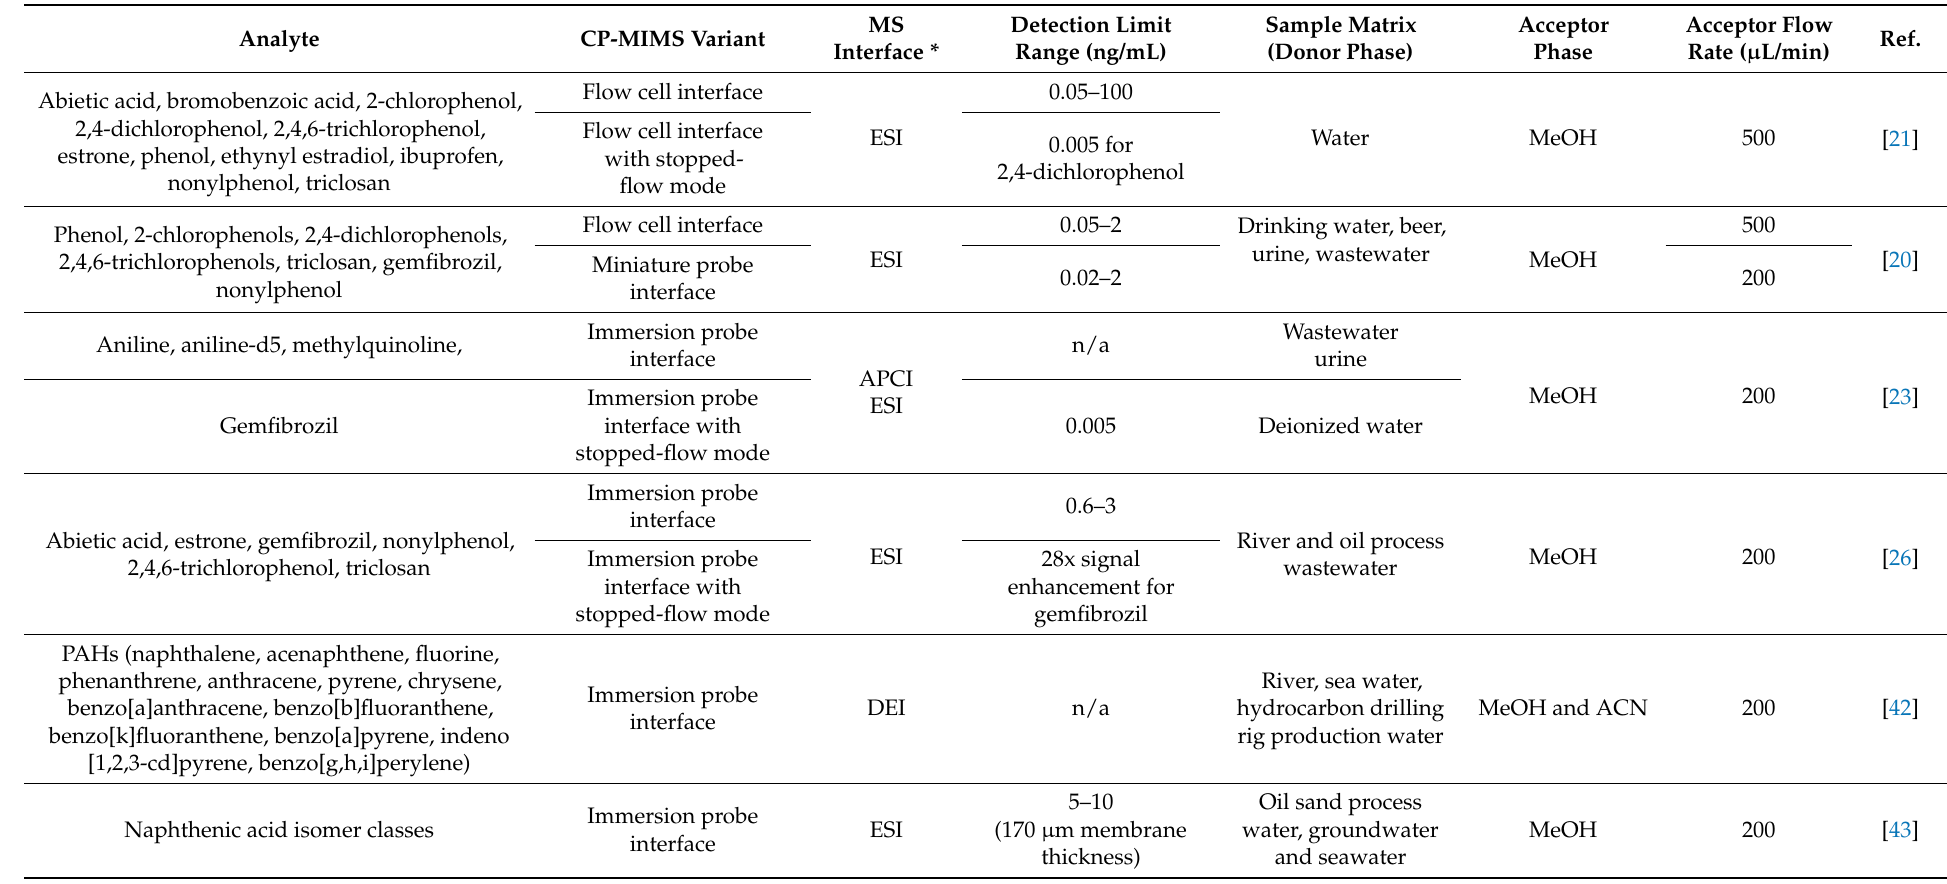
Table 1. Detailed list of CP-MIMS variant, mass spectrometric interface, limits of detection, and donor and acceptor phases, acceptor flow rate used in the different